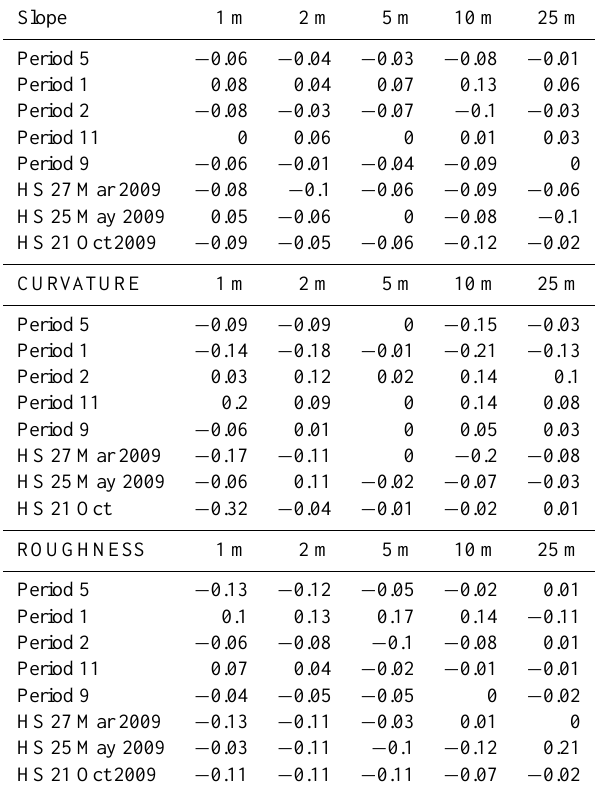
Table 6. Persons Correlation coefficients between snow depth (HS) and HS change distributions of different periods (see Table 3), re- spectively on different days, and terrain parameters with different cellsizes.